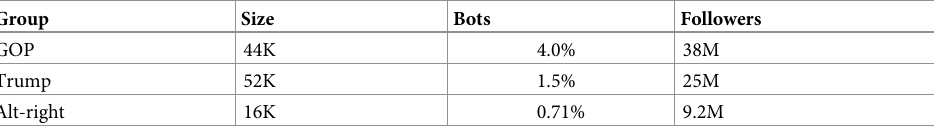
Table 1. The three focal groups have few bots and are widely followed by other accounts on Twitter. We estimated numbers of bots by testing 2,000 accounts using Botometer [24] (scores > 0.8 were deemed bots). The number of fol- lowers was the number of unique accounts on the whole of Twitter that had followed at least one account in each group. The number of followers for all three groups combined is 57 million, comparable in size to the 63M who voted for Trump in the election. Figures are given to 2 d.p., K means thousands, and M means millions. Group Size Bots Followers GOP 44K 4.0% 38M Trump 52K 1.5% 25M Alt-right 16K 0.71% 9.2M